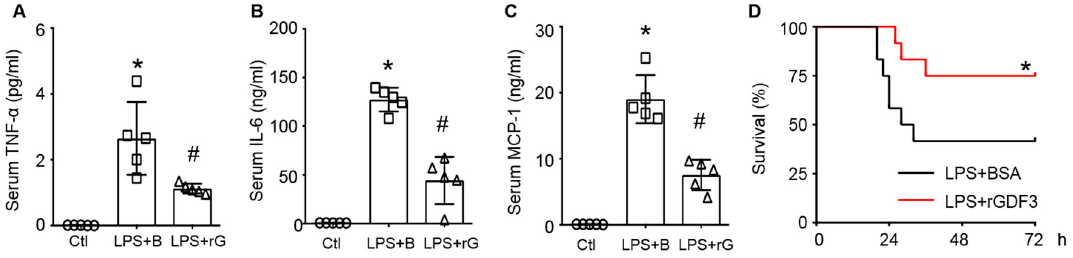
Figure 5. Recombinant GDF3 protein attenuates inflammatory response and mortality in endotoxin-induced septic mice. WT mice injected with rGDF3 protein (I.P., 10 µ g / kg BW) 12 h prior to LPS injection (I.P., 10mg / kg BW), 12 h later serum was collected for measuring ( A ) TNF- α , ( B ) IL-6, and ( C ) MCP-1 levels (*, p < 0.05 vs. Ctl; #, p < 0.05 vs. LPS + B; n = 5). ( D ) Kaplan-Meier survival curves were generated for LPS-mice treated with or without rGDF3 (*, p < 0.05; n = 12).